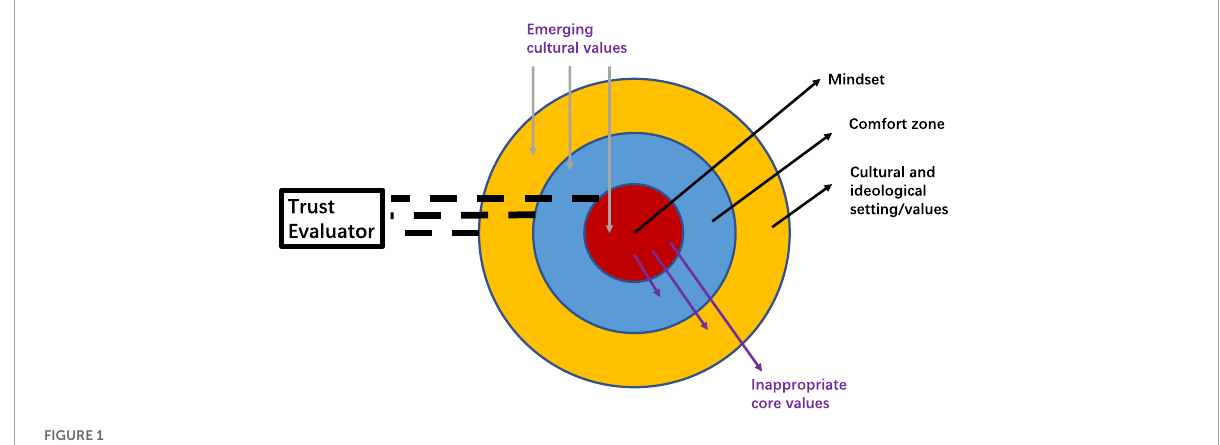
FIGURE1 A modified version of mindsponge mechanism (Vuong and Napier, 2015).